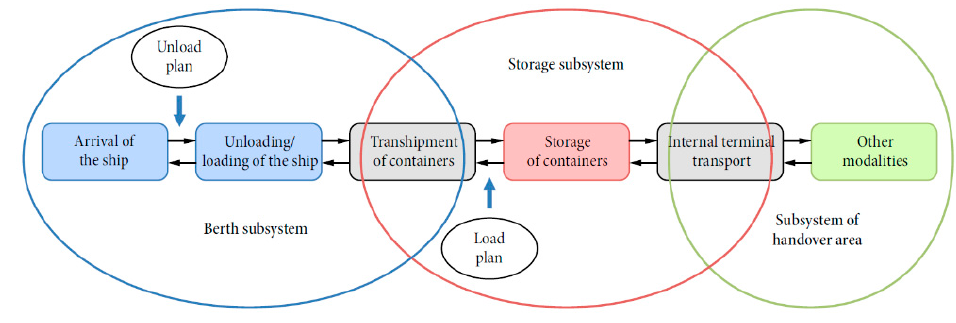
Figure 1. Processes at a container terminal [5].